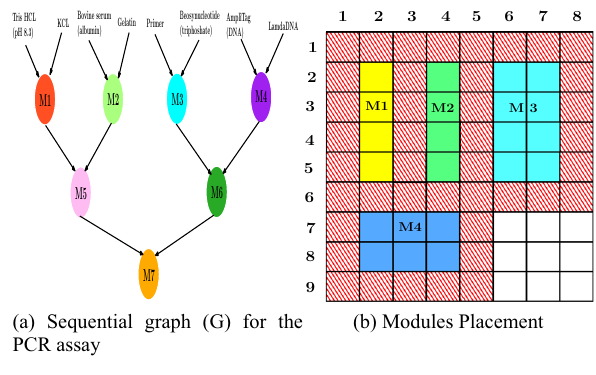
Fig. 5 PCR assay synthesis on a conventional 8 × 8 DMFB